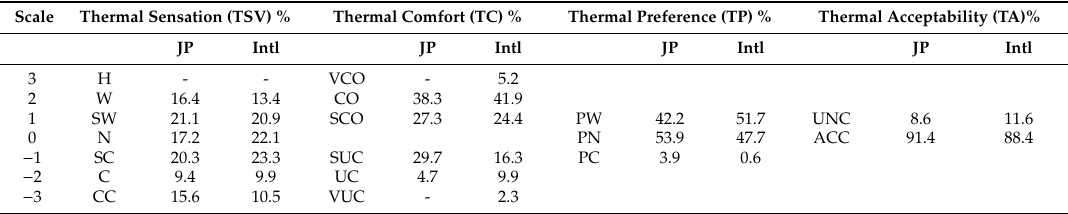
Table 4. Percentage of thermal responses for each scale relative to nationality (Japanese: N = 128; international: N =